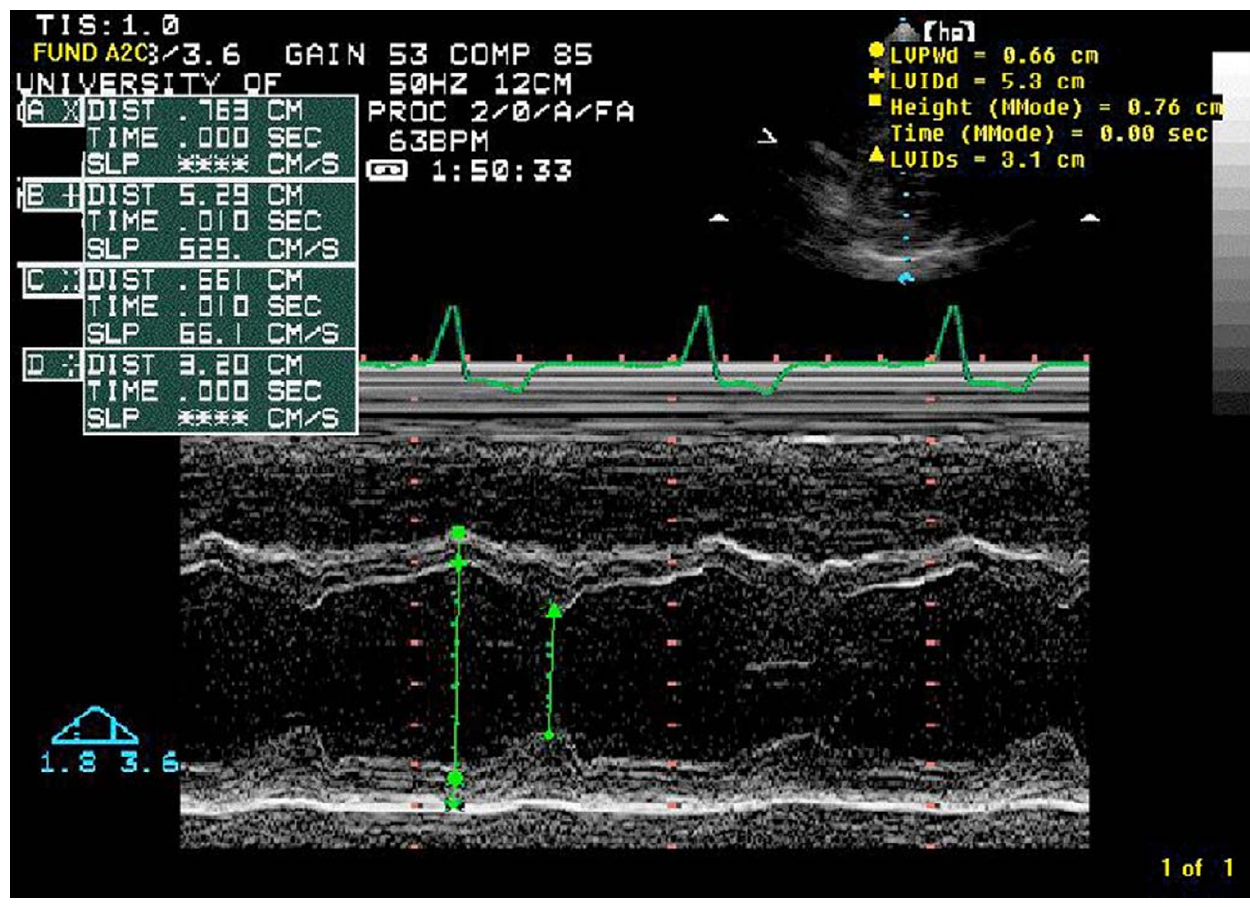
Echo Shown is an M-mode echocardiogram through the diameter of the left ventricle revealing mild dilation. The left vertical line marks the dimension of the ventricle in diastole at its greatest, and this dimension is 5.3 cm (above the 95 th percentile for body mass index). The fractional shortening was normal and the ejection fraction was read as low normal consistent with the mildly dilated left